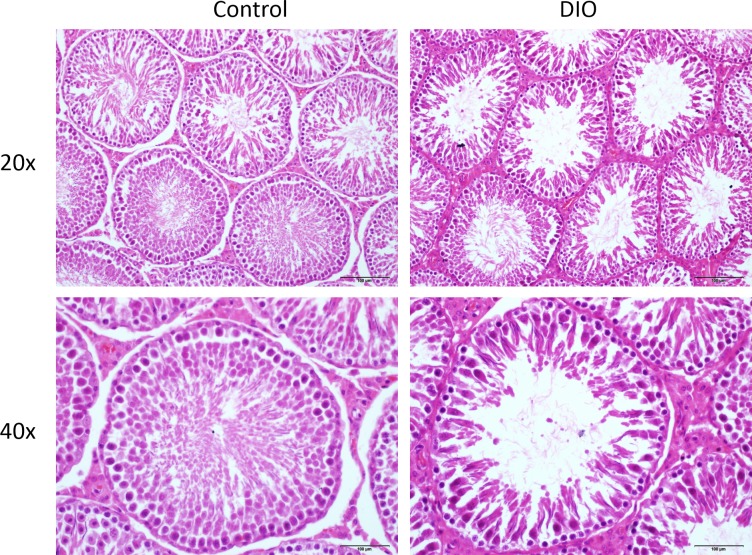
HE staining in the testis of control and high fat diet fed SD rat (original magnification, 20 × and 40 ×).